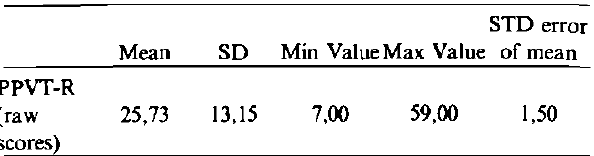
Table 2: Descriptive statistics of the group's performance on the PPVT-R (Afrikaans translation).